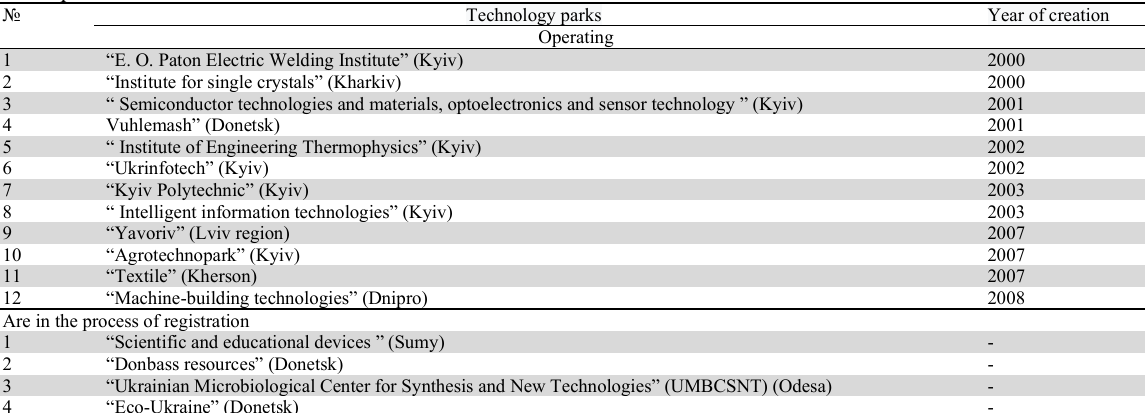
Technoparks of Ukraine № Technology